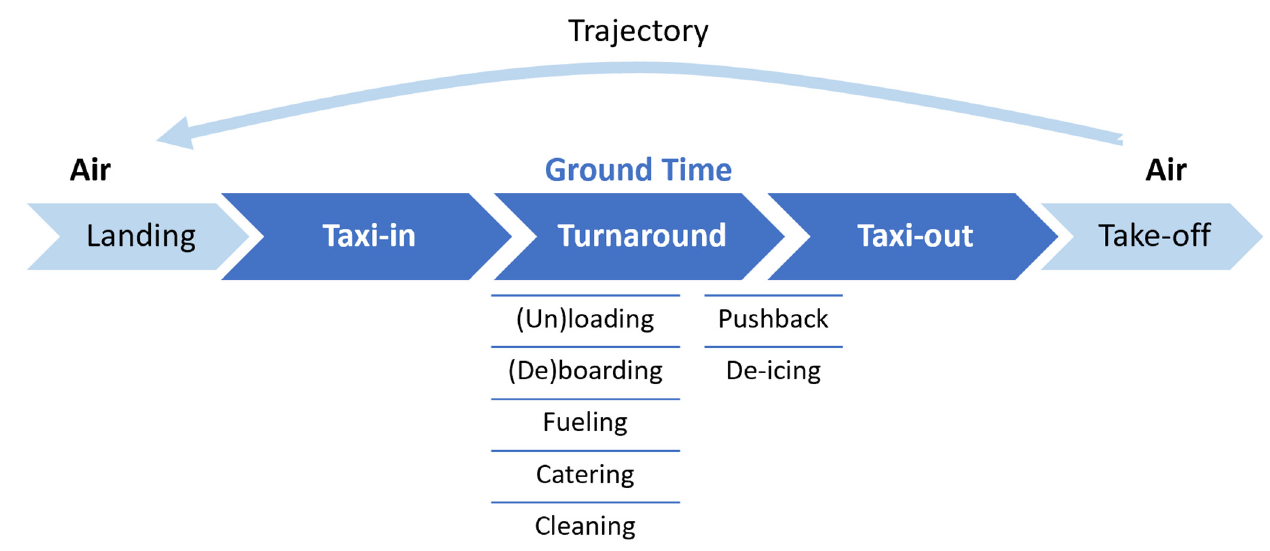
Figure 1. Ground time as part of one flight operation.